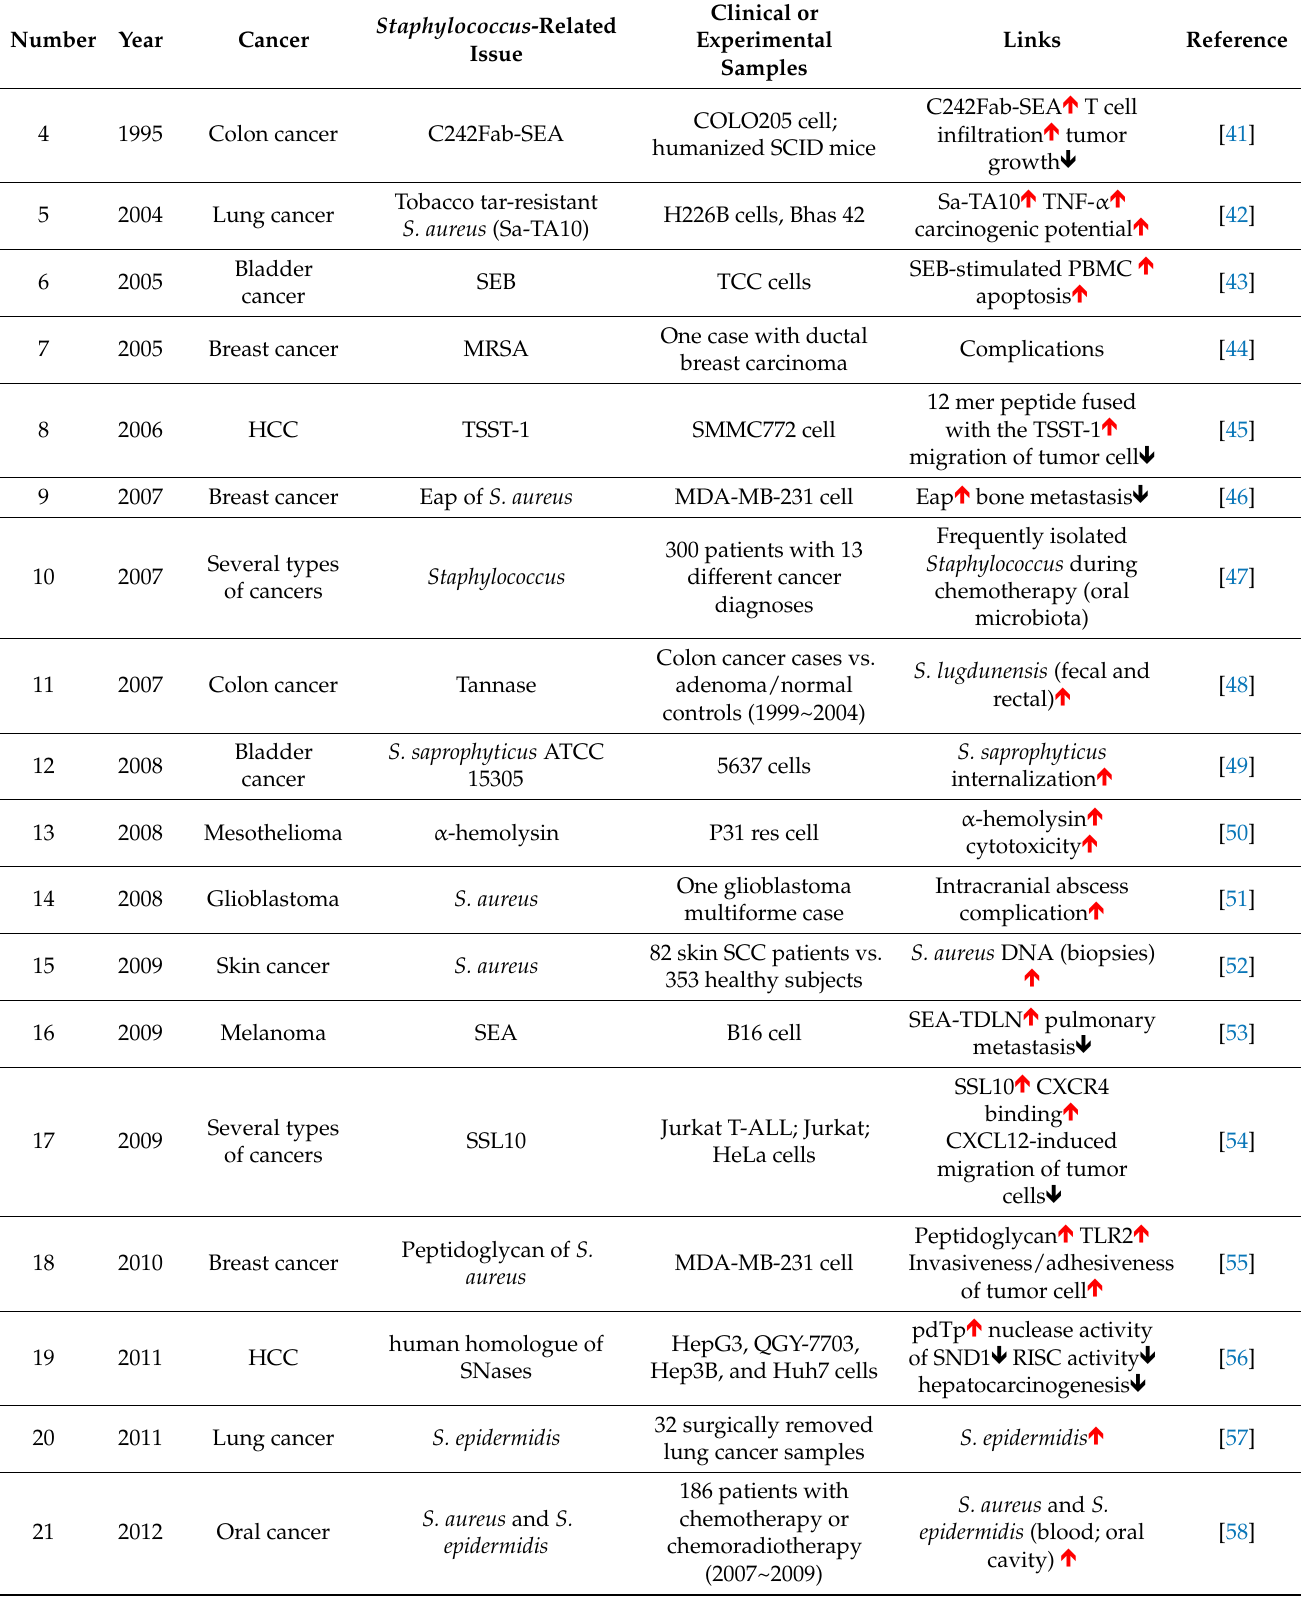
Table 1. Summary of evidence on Staphylococcus and